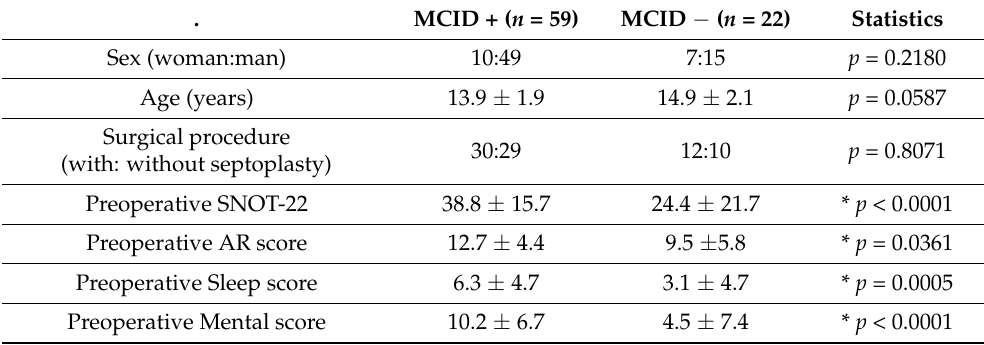
Preoperative Mental score